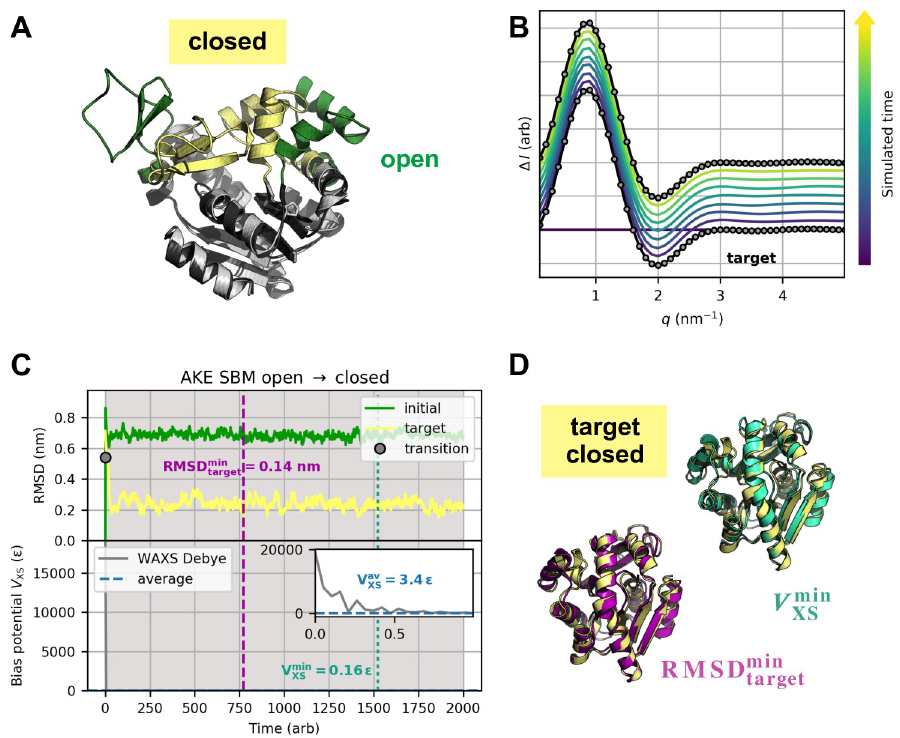
Fig 2. Method validation using the example of AKE’s open-to-closed transition. Results are shown for parameters ( T , k χ ) = (50, 8 � 10 − 9 ε ). (A) AKE test system. Open (green) and closed (yellow) conformations with CORE domain (grey) spatially aligned. (B) Artificial target data (grey circles) were computed from absolute Debye intensities. Theoretical difference curves of simulated structures (blue to yellow) almost perfectly match the target data and were plotted with small offsets. (C) Initial and target RMSD (top) and bias energy (bottom) versus simulated time. (D) Best structures as measured by target RMSD and bias energy. RMSD min structure (purple) and V min structure (turquoise) XS target exhibit target RMSDs of 0.14 nm and 0.20 nm,